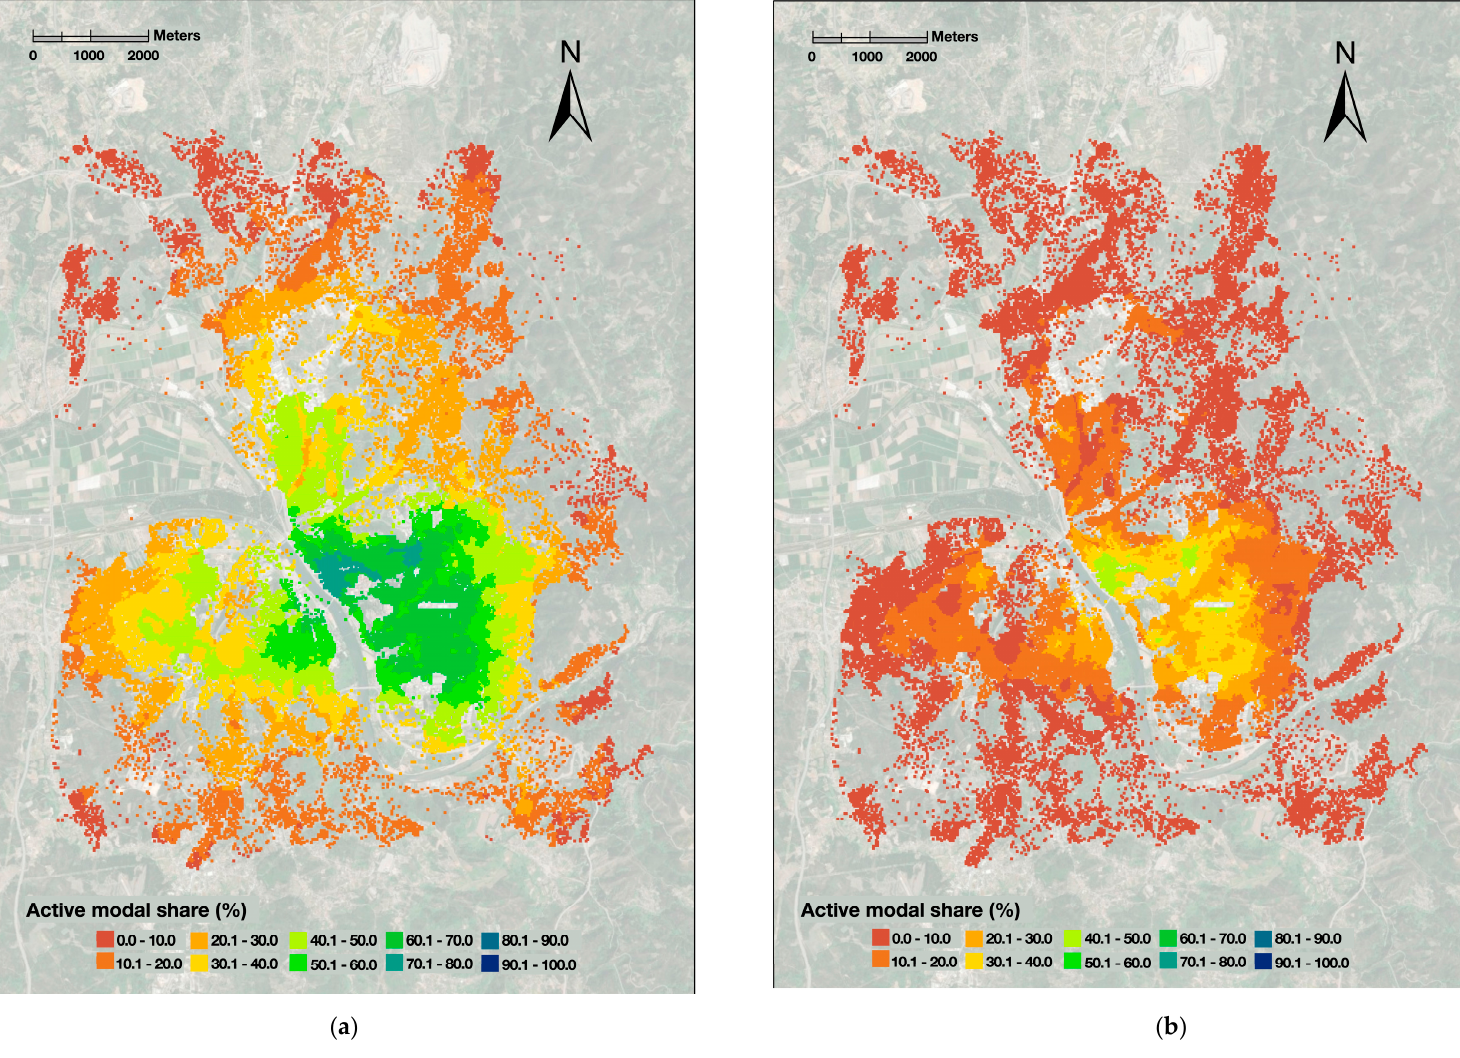
Figure 3. ( a ) Active modal share for full cycling: facilities and jobs; ( b ) Active modal share for no cycling: facilities and jobs .